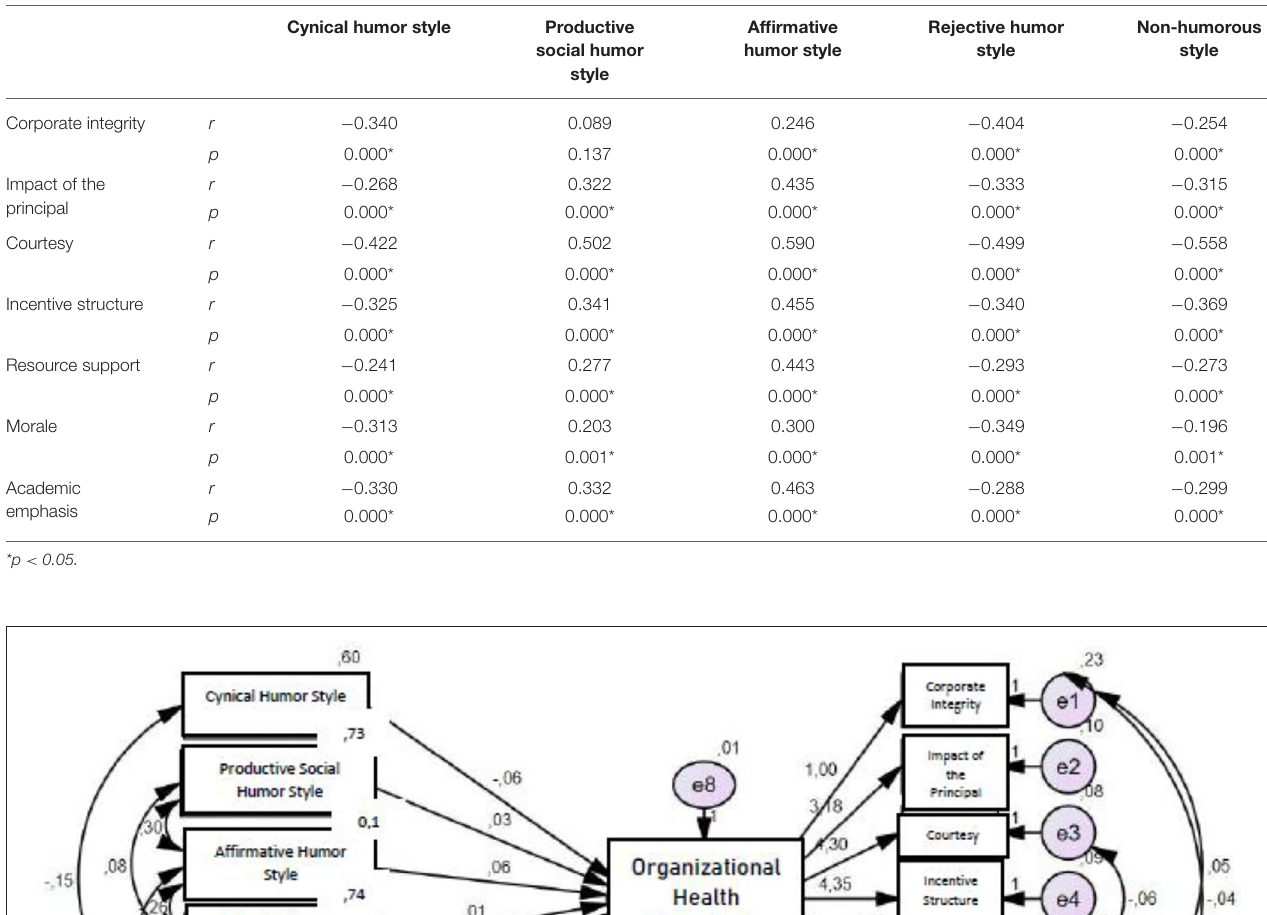
TABLE 4 | Correlations between the scores of the teachers’ humor behavior scale and organizational health inventory ( n = 283).